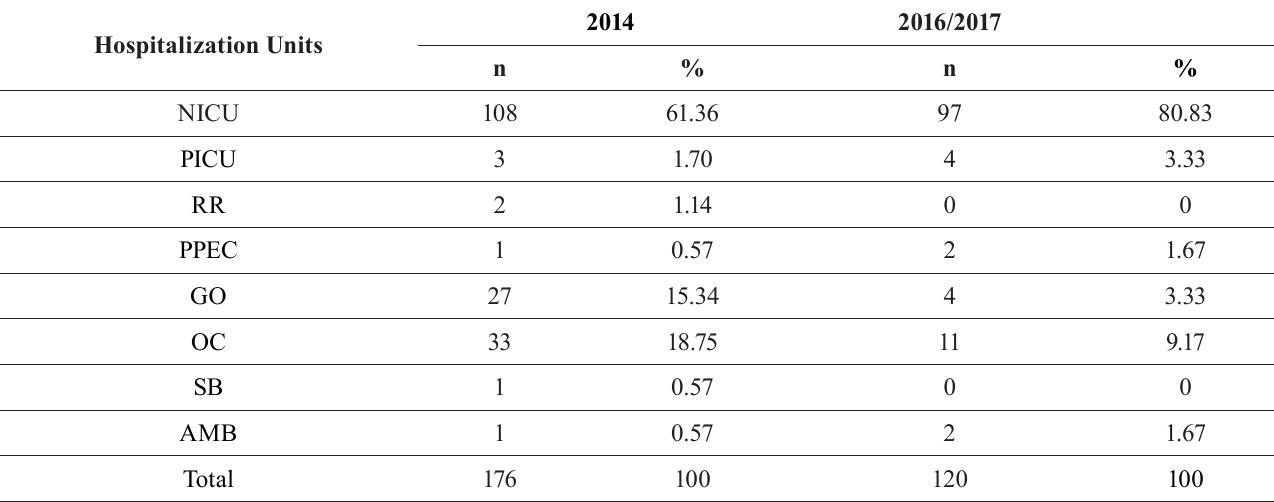
TABLE II – Distribution of blood cultures in which there was the isolation of coagulase-negative staphylococci (CoNS) and respective hospitalization units, in 2014 and 2016/2017, in a tertiary hospital in the southern region of Brazil